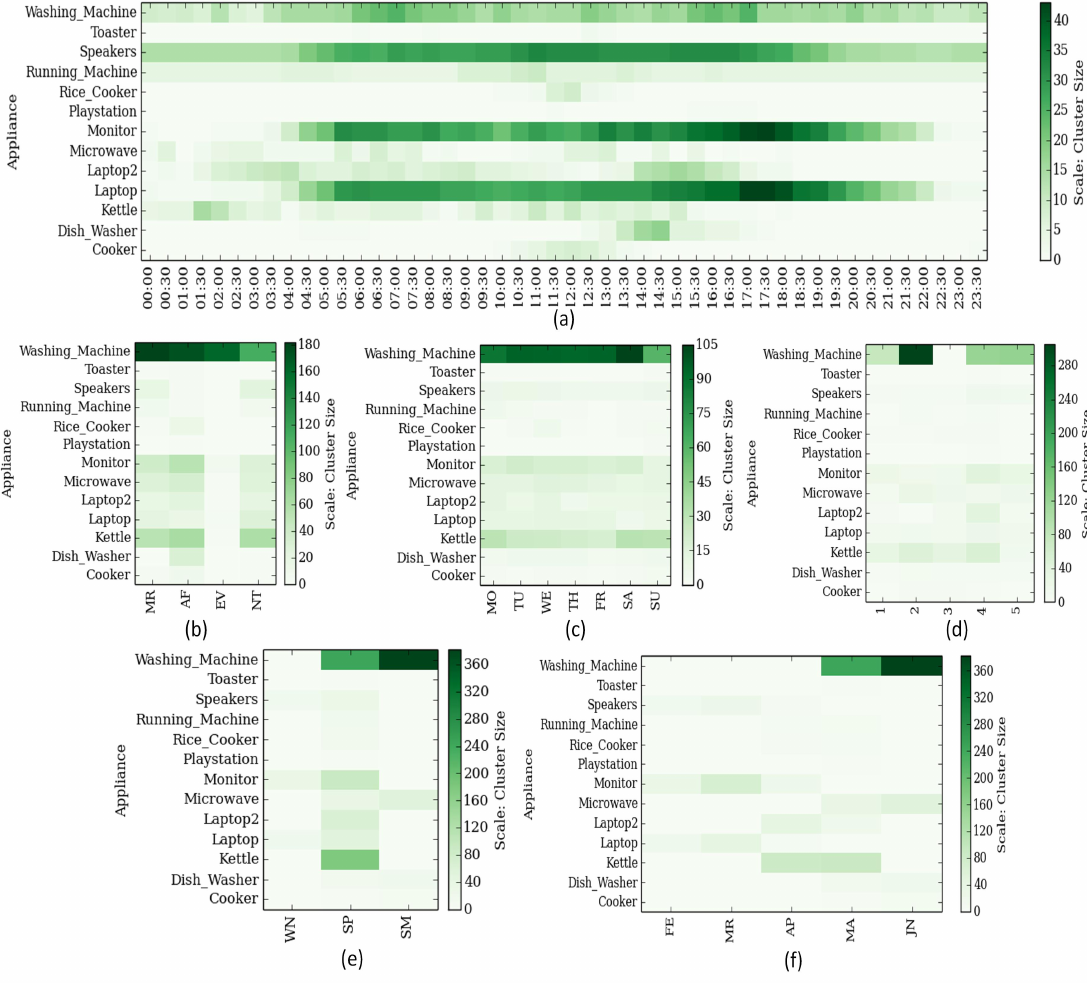
Figure 3. House 3: appliance-time associations [25% training dataset], ( a ) appliance-hour of day; ( b ) appliance-time of day; ( c ) appliance-weekday; ( d ) appliance-week; ( e ) appliance-season; ( f )